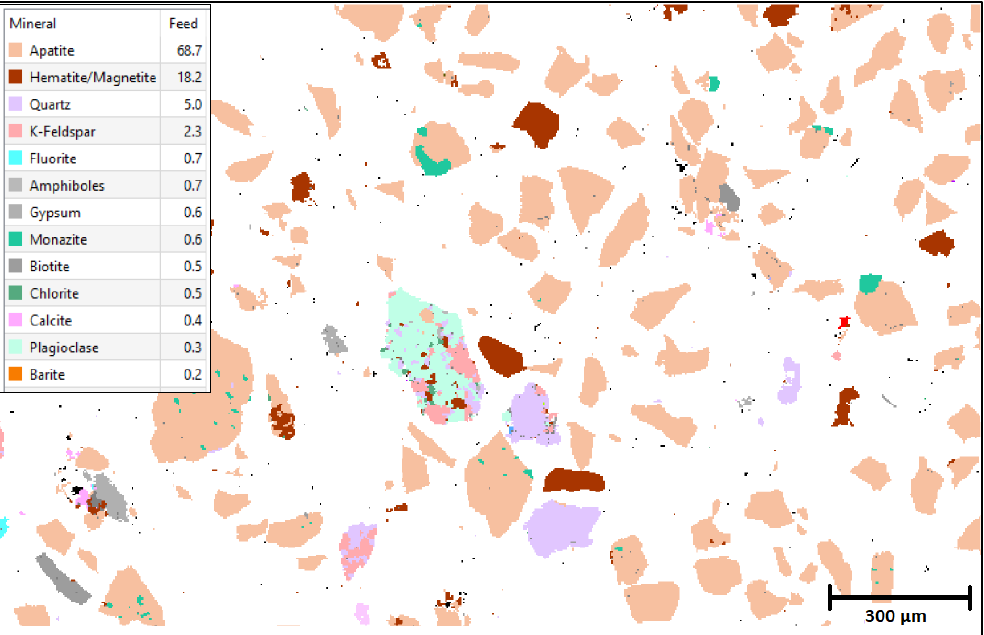
Figure 2. False-color TIMA image shows mineral associations in the flotation feed. Monazite (blue- green) is seen as large grains attached primarily to apatite grains. Table 1. Distribution of major REEs within the dominant REE minerals in the flotation feed as re- vealed by TIMA.